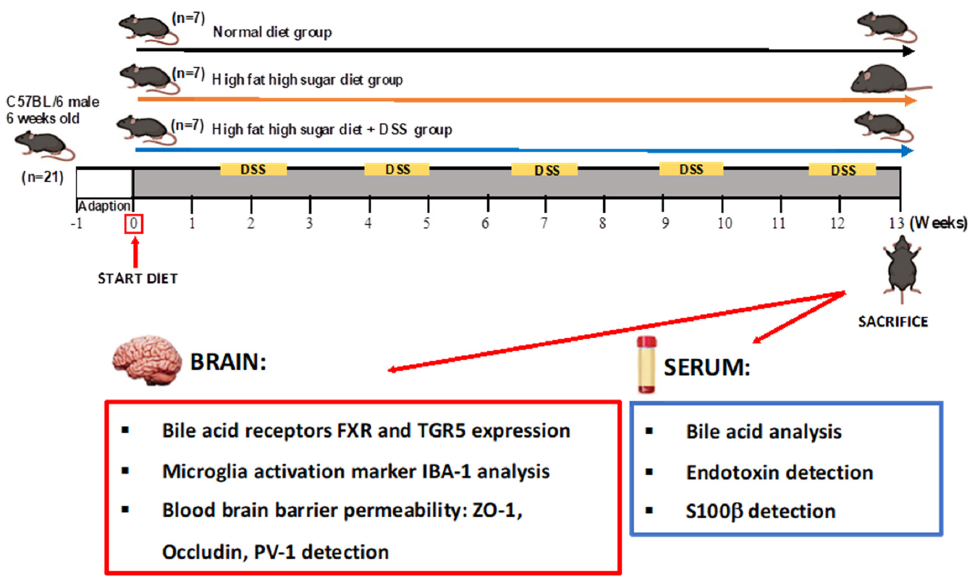
Figure 1. Experimental design scheme. Animals were randomly divided into 3 groups: (1) standard pellet diet and tap water (CTRL group) ( n = 7); (2) high fat diet plus high sugar (HFHSD group as a model of NAFLD) ( n = 7); (3) HFHSD with cyclic administration of 1% ( w / v ) DSS, in drinking water (HFHSD-DSS group as a model of NASH) ( n = 7). Mice were fed with standard diet or HFHSD for the duration of the whole experiment, and the HFHSD-DSS group was exposed to 5 cycles of DSS. After 13 weeks of treatment, mice were sacrificed and brains were collected for BA receptors, Iba-1, ZO-1, Occludin and PV-1 analyses and serum was collected for BAs, S100 β protein and endotoxin analyses.